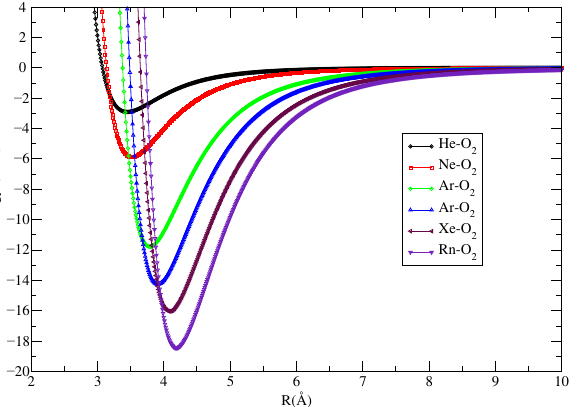
Figure 2. Improved Lennard Jones potential energy curves for the Ng–O 2 compounds obtained at CCSD(t)/aug-cc-pVTZ level with the BSSE correction.